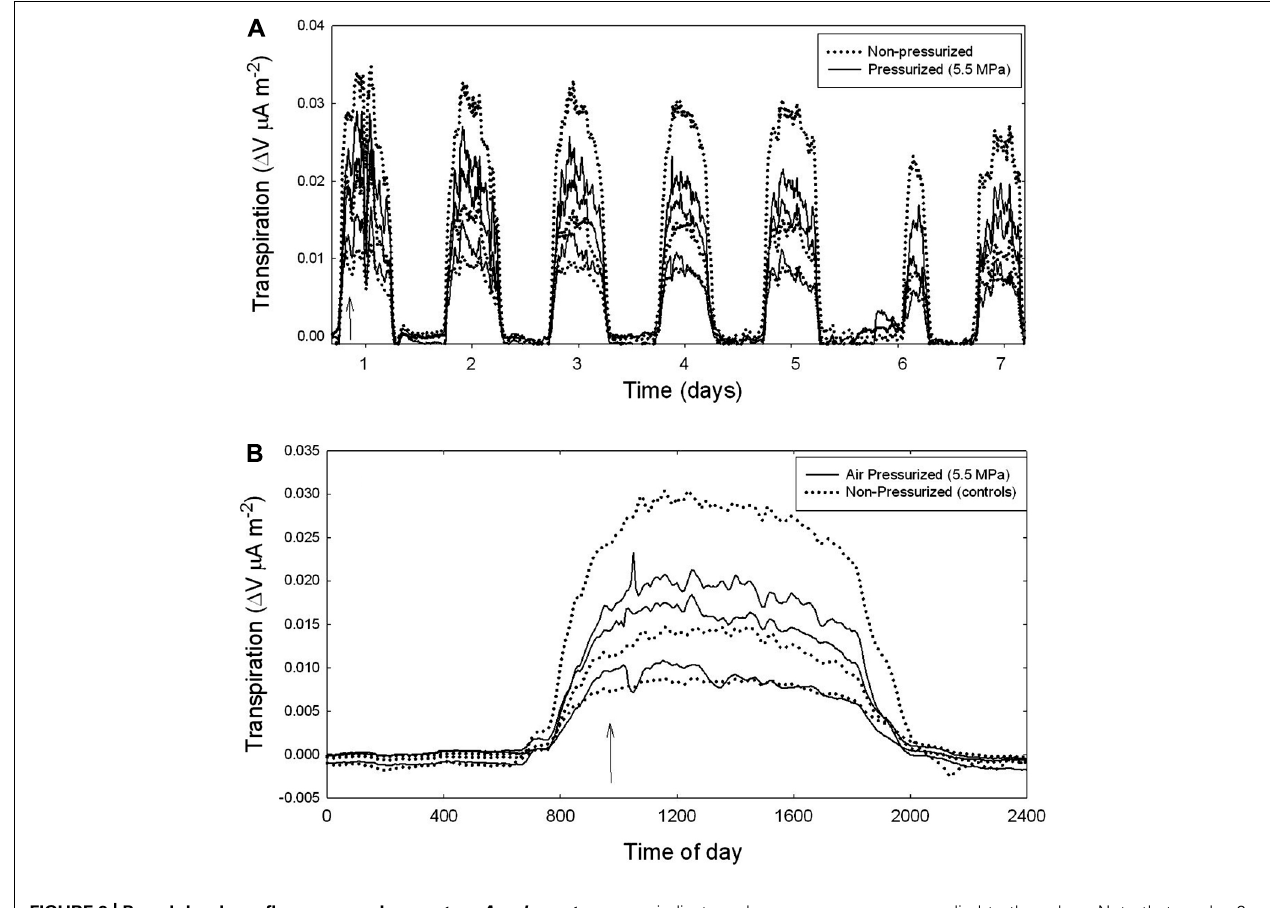
indicates when gas pressure was applied to the xylem. Note that on day 6 it was raining in the morning resulting in low flow rates for all branches measured. (B) The effects of air-pressurization on sap flow shown for a 24-h period. All branch-level measurements are standardized by total leaf